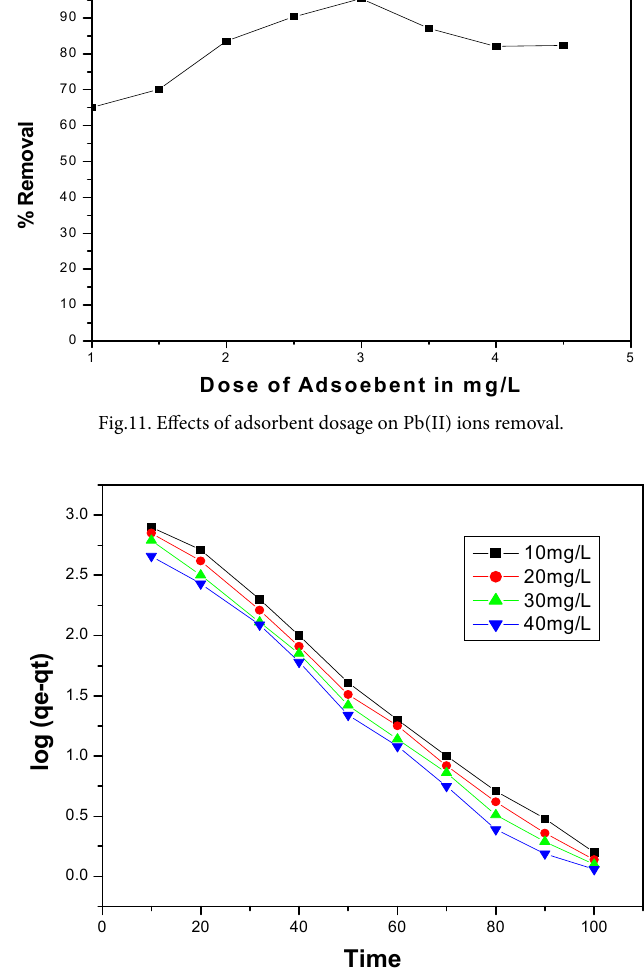
Fig.12. Pseudo First Order kinetics of Pb(II) metal ions Adsorption on magnetic nano